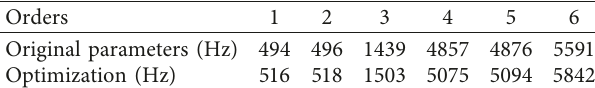
Figure 15: Dynamic response of aerostatic spindle.